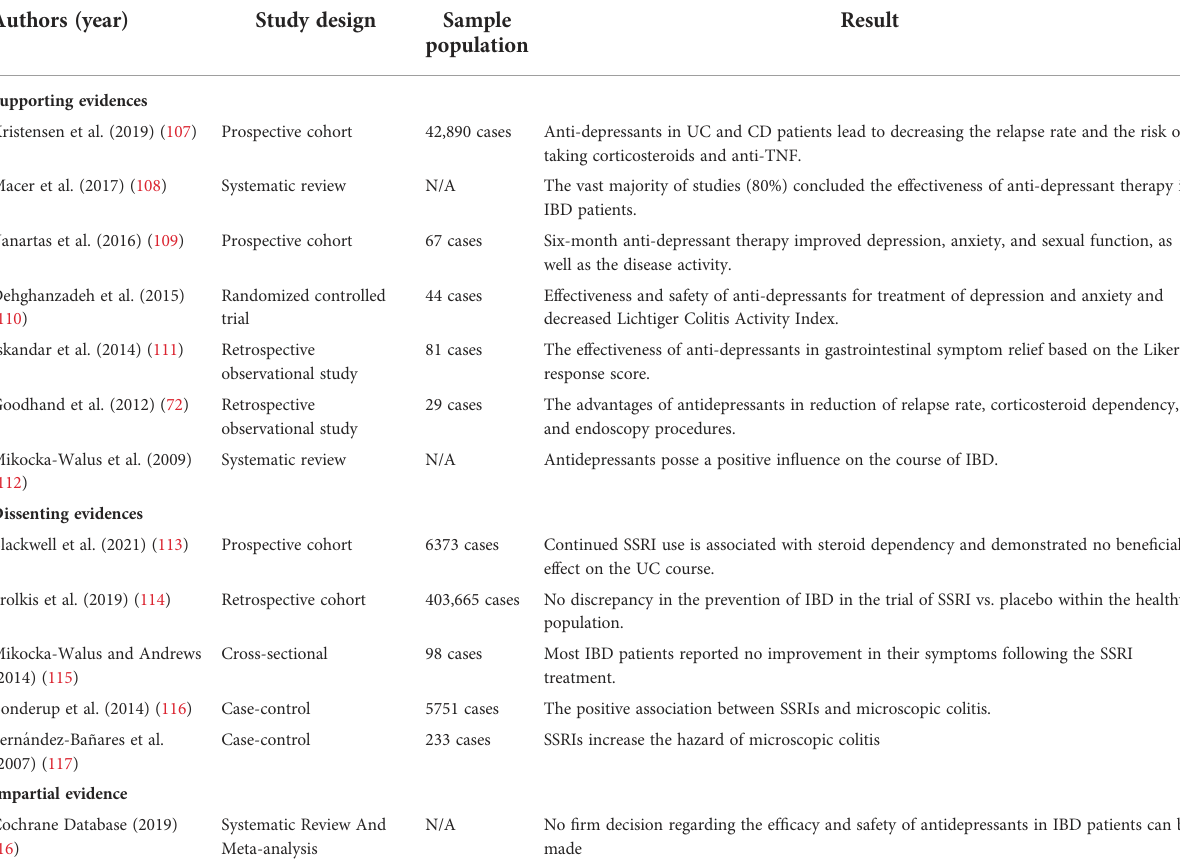
TABLE 1 Clinical documents of SSRI